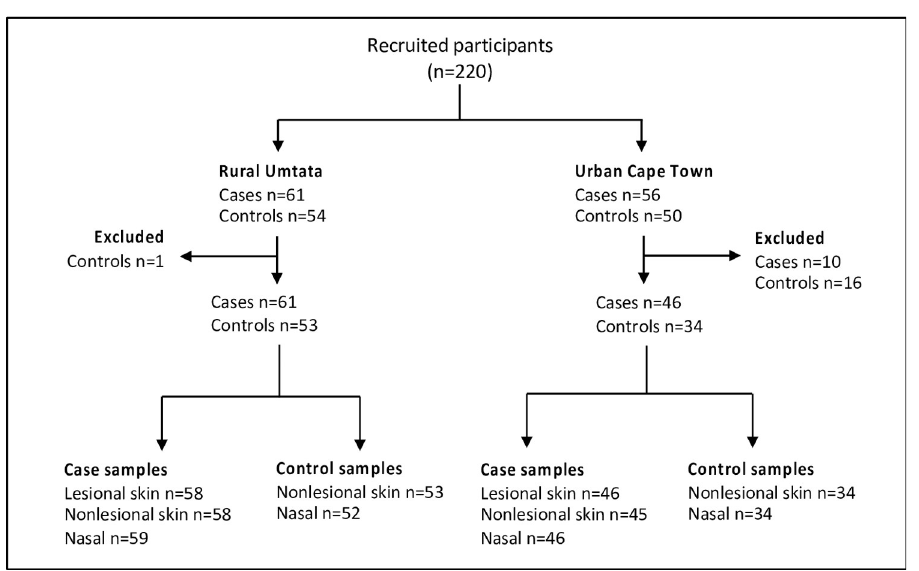
Fig 1. Flow chart of study participant specimens included in the analyses. Twenty-seven participants were excluded from analysis due to the unavailability of samples. anterior nares (cases: n = 67; controls: n = 25) from cases and controls (Fig 1). These isolates represented 16 different staphylococcal species including S . aureus (n = 129), S . epidermidis (n = 104), S . hominis (n = 53), S . haemolyticus (n = 38), S . capitis (n = 28), S . saprophyticus (n = 10), S . warneri (n = 5), S . cohnii (n = 4), S . equorum (n = 2), S . pasteuri (n = 2), S . caprae